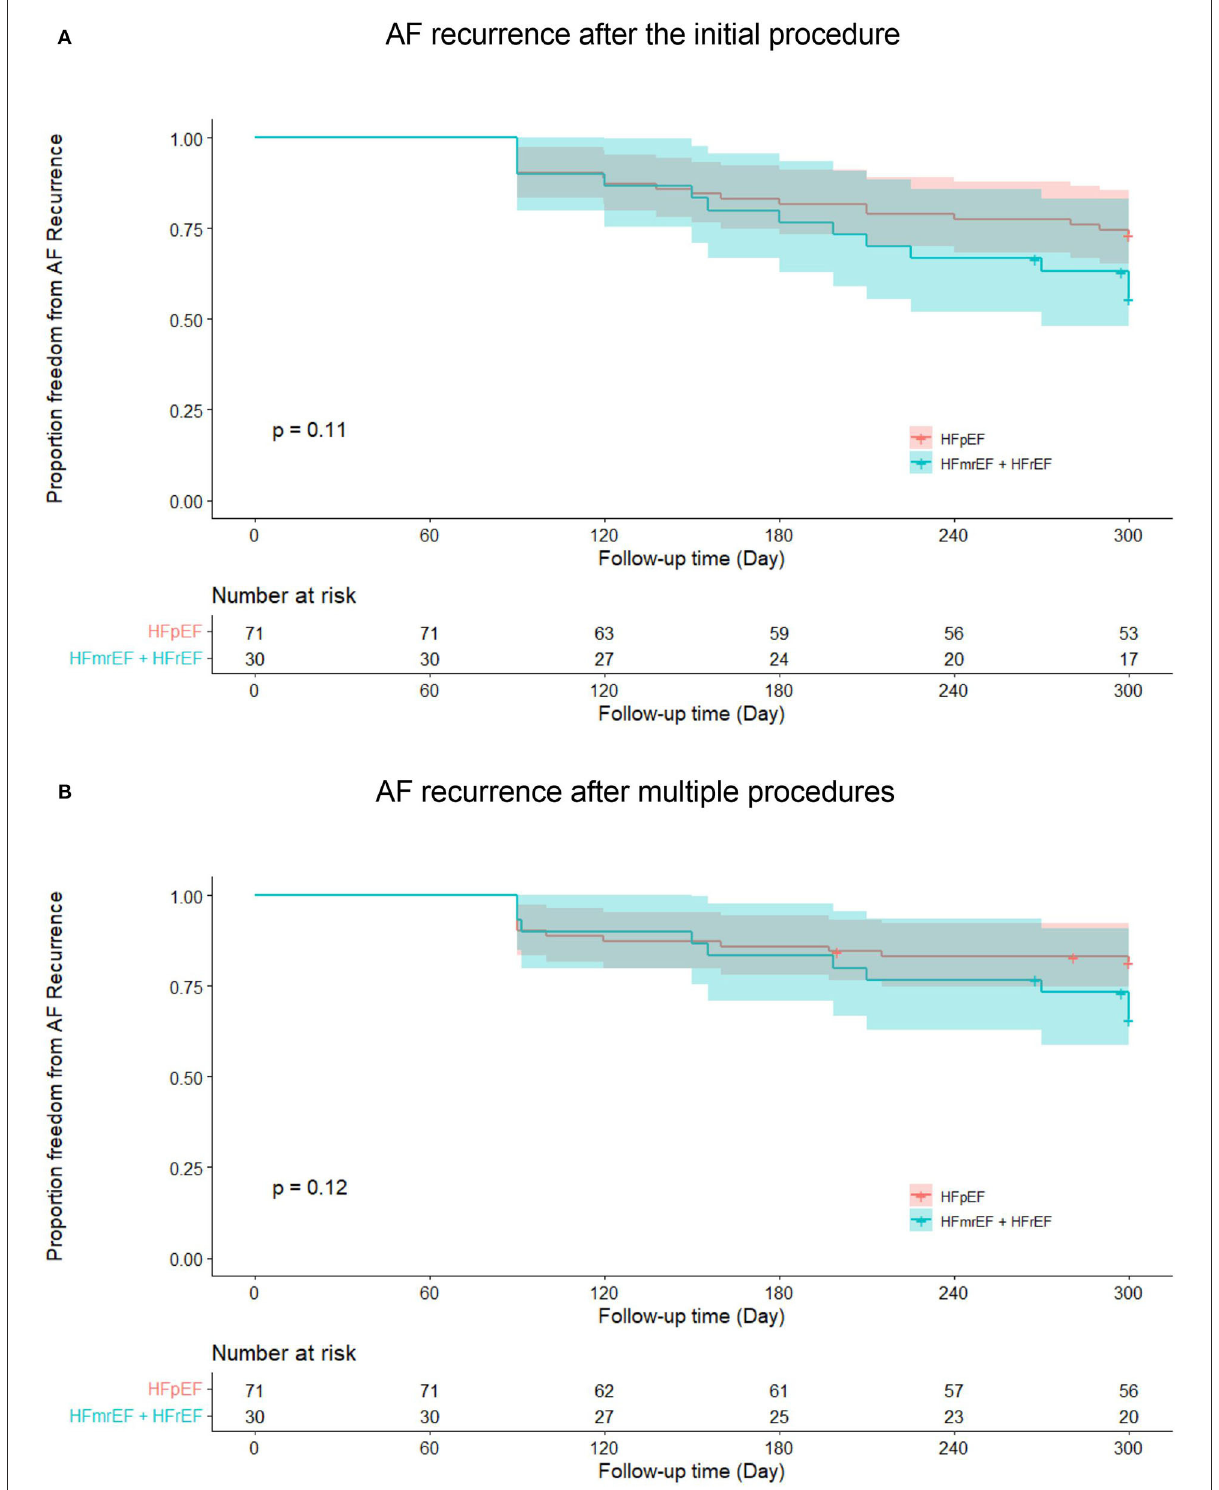
FIGURE2 Kaplan–Meier curves show AF recurrence after the initial (A) and multiple procedures (B) in heart failure with preserved ejection fraction and heart failure with mid-ranged ejection fraction + heart failure with reduced ejection fraction groups. AF, atrial fibrillation; HFpEF, heart failure with preserved ejection fraction; HFmrEF, heart failure with mid-range ejection fraction + heart failure; HFrEF, heart failure with reduced ejection